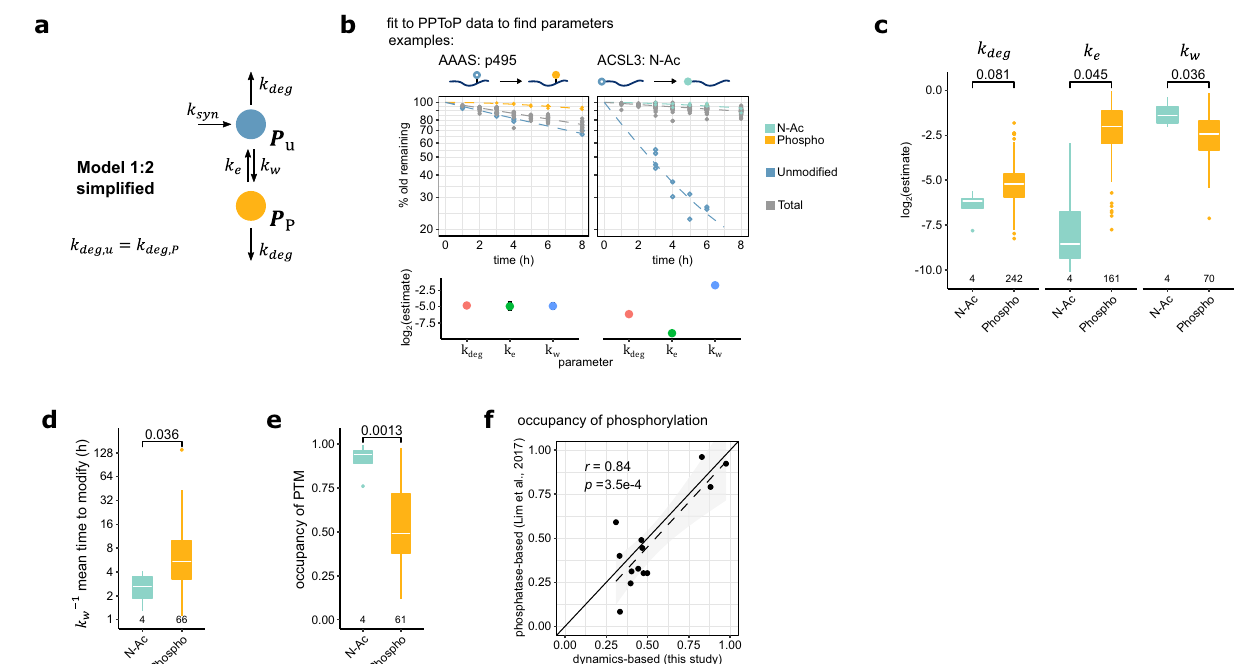
Fig. 7 | Extracting parameters of PTM dynamics from PPToP data. a Simpli fi ed shorterinN-Acindicatingfastermodi fi cation.Two-sided t test( t = − 3.06,df=4.16). e Steady-state occupancy of PTM (stoichiometry of modi fi cation) estimated from Model 1:2 used for fi tting. b Upper panel: example clearance traces and fi ts of two fi tted parametersshow signi fi cantly higher occupancy for N-Acmodi fi edpeptides. proteins. The N-Acylated or phosphorylated species are treated as the modi fi ed species P P in the fi t. Lower panel: estimates for the different parameters for the Two-sided t test( t =6.17,df=5.28). f Occupancyofphosphorylationsitescalculated proteins shown above. Shown are parameter estimates and standard deviations. from PPToP dynamics-based parameters agree well with experimental estimates. c Writing and erasing rates, but not degradation are signi fi cantly different in N-Ac Pearson correlation. p value for null hypothesis testing, i.e., no correlation (two- and phospho cases. Only parameters fi tted with high con fi dence are shown (see sided).The shadedregion indicates the95% con fi denceintervalofthe fi t.Boxplots − 2.45, df = 3.15; k − 3.3, df = “ Methods ” for details). Two-sided t tests ( k in c , d , and e consist of median line, box: upper and lower quartiles, whiskers: 1.5 deg , t = e , t = 3.03; k w , t =3.08,df=4.05).Theconclusionswereunaffectedbythespeci fi ccutoff times interquartile range, points: outliers. Source data are provided as a Source for con fi dence used. d Theoretical mean time to modify ( k w − 1 ) is signi fi cantly data fi